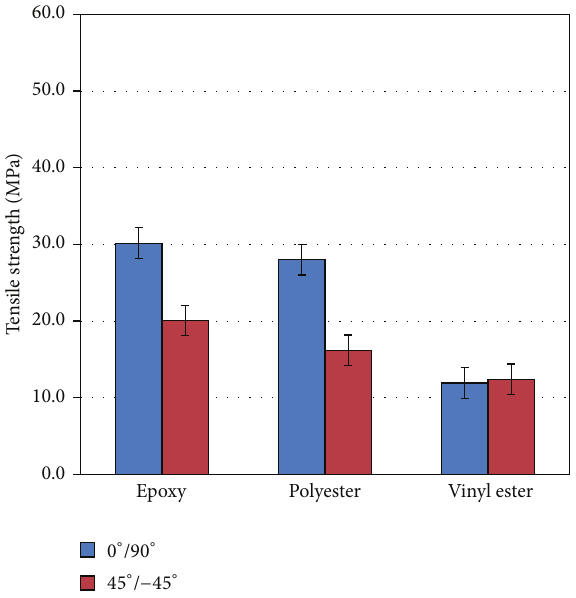
Figure3:Tensilestrengthofthreecompositesat0 ∘ /90 ∘ and45 ∘ / − 45 ∘ orientation.